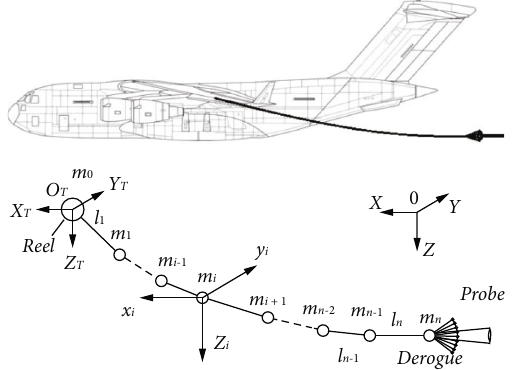
Figure 1: Coordinate systems and hose-drogue model during hook-up.